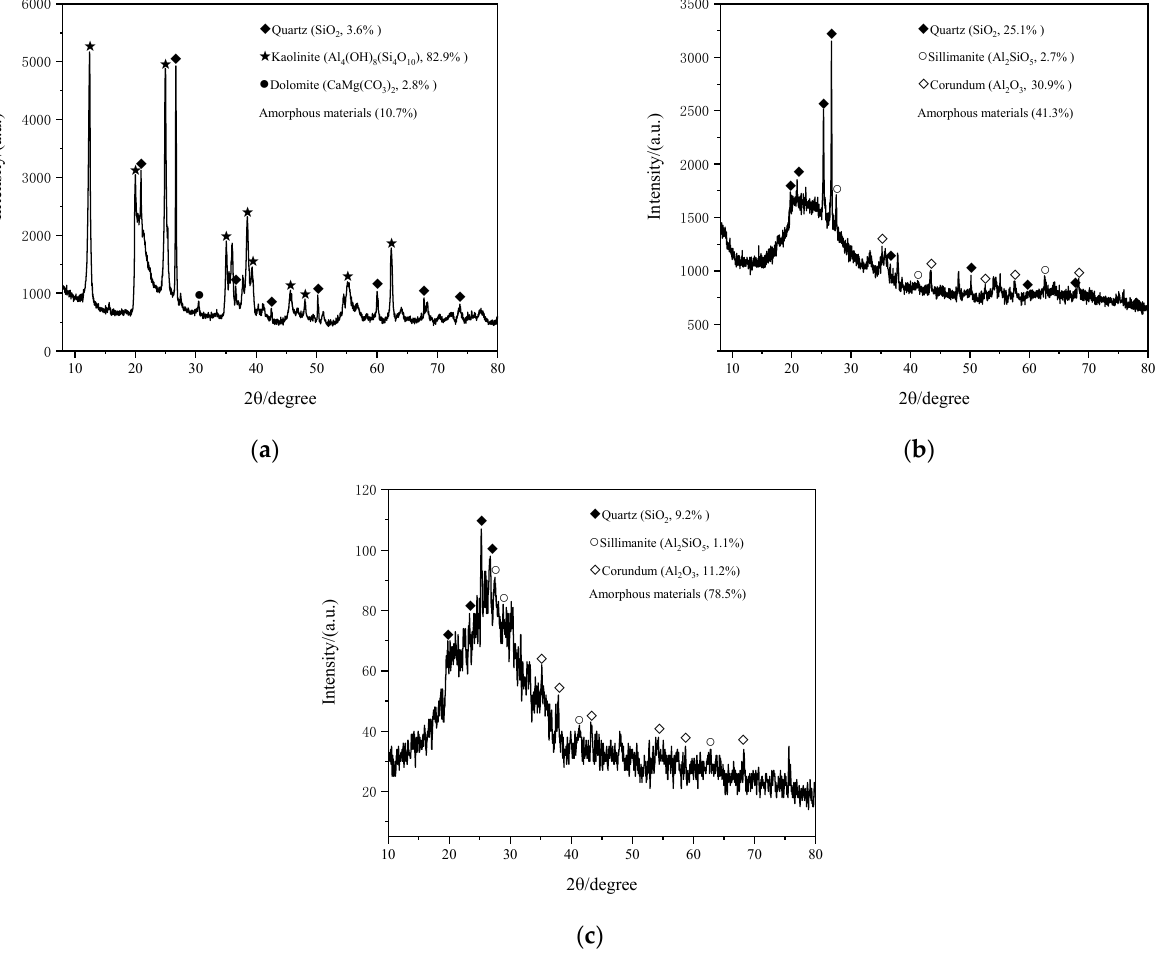
Figure 3. XRD of coal ‐ based kaolin ( a ), metakaolin ( b ) and alkali ‐ activated metakaolin ( c ). According to previous studies, the chemical shift of four ‐ coordinated aluminum (Al (IV)) in silicon aluminum compounds is at 50 ± 20 ppm [16,17]. With respect to Al (H 2 O) 63+ , the chemical shift of five ‐ coordinated aluminum (Al (V)) is at 30 ± 10 ppm, and the six ‐ coordinated aluminum (Al (VI)) is at 0 ± 15 ppm [18,19]. Before calcination of coal ‐ based kaolin, aluminum (Al) mainly existed in kaolinite crystals in the form of Al (VI) with a chemical shift of 2.55 ppm (Figure 4a) because kaolinite (Al 4 (OH) 8 (Si 4 O 10 ) accounted for the most (82.9%) while no aluminum existed in quartz (SiO 2 ) and dolomite (CaMg(CO 3 ) 2 ) (Figure 3a). Figure 5a shows a typical layered structure of kaolinite. In the NMR of coal ‐ based metakaolin, there was the main peak at 13.1 ppm, and a small peak at 5.44 ppm (Figure 4b), which proved that after calcination, most of the aluminum still existed in the form of Al (VI) (Figure 4b), and the mineral composed of Al (VI) here was no longer kao ‐ linite, but sillimanite and corundum crystals and amorphous aluminum silicate. The con ‐ tent of corundum crystal was much higher than that of sillimanite because Al in sillima ‐ nite usually exists in the form of Al (VI) and Al (IV) at the same time, while the Al detected in Figure 4b was still dominated by Al (VI); this was also verified by the quantitative anal ‐ ysis of XRD in Figure 3b (2.7% sillimanite and 30.9% corundum). Figure 5b shows that after calcination, the obvious layered structure of kaolin had been destroyed and replaced by the disordered scale ‐ like arrangement structure.